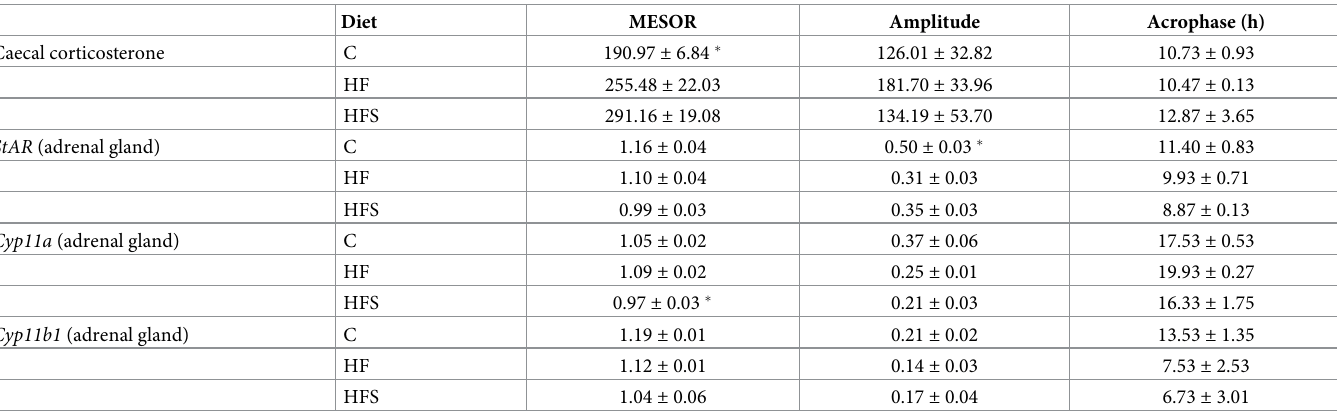
Data shown in Fig 3 analyzed using cosinor analysis. MESOR, mean statistics of rhythm; amplitude, one-half the total peak-through variation; acrophase, hours delay from ZT0; C, control diet; HF, high-fat diet; HFS, high-fat and high-salt diet. Values are means ± SE. � p < 0.05 (vs.